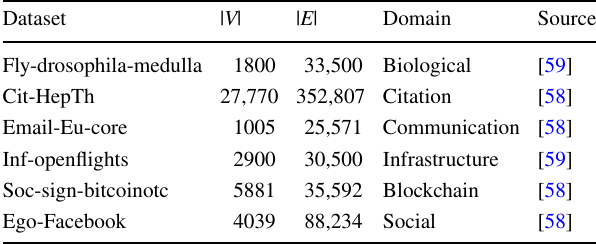
Table 3 Empirical graph datasets Dataset